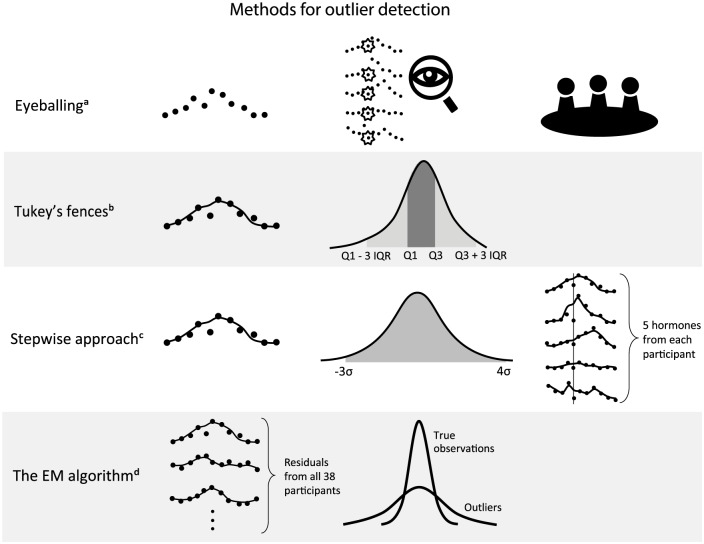
(a) Eyeballing detects outliers without fitting smooth curves. By visual inspection, individual experts detect outliers by taking into account that some hormones were measured in a same sample. Afterward, a consensus meeting is held, and the experts discuss all data points with conflicting detection results. (b) Tukey’s fences starts with fitting a moving average curve to per-person per-hormone data and taking residuals of all data points. Then the interquartile range (IQR = Q3–Q1) of the residuals is calculated. The data points lying outside the range between Q1 − 31QR and Q3 + 3IQR are detected as outliers. (c) The stepwise approach fits the moving average curve to per-person per-hormone data, and standardized residuals of all data points are calculated (step 1). The data points lying outside the range between −3 and 4 standard deviations are detected as outliers (step 2). Then, the residuals of 5 hormones measured at the same time points are summed. When the sum of the residuals is smaller than −8, the data points are detected as outliers (step 3). Afterward, steps 1 and 3 are repeated (step 4). (d) The expectation-maximization (EM) algorithm first fits a smoothing curve to per-person per-hormone data, and the residuals are calculated. Then, all the residuals of a hormone from all 38 participants are put in the EM algorithm. The algorithm then identifies 2 distinguishable distributions and yields the probability of each data point to be an outlier.